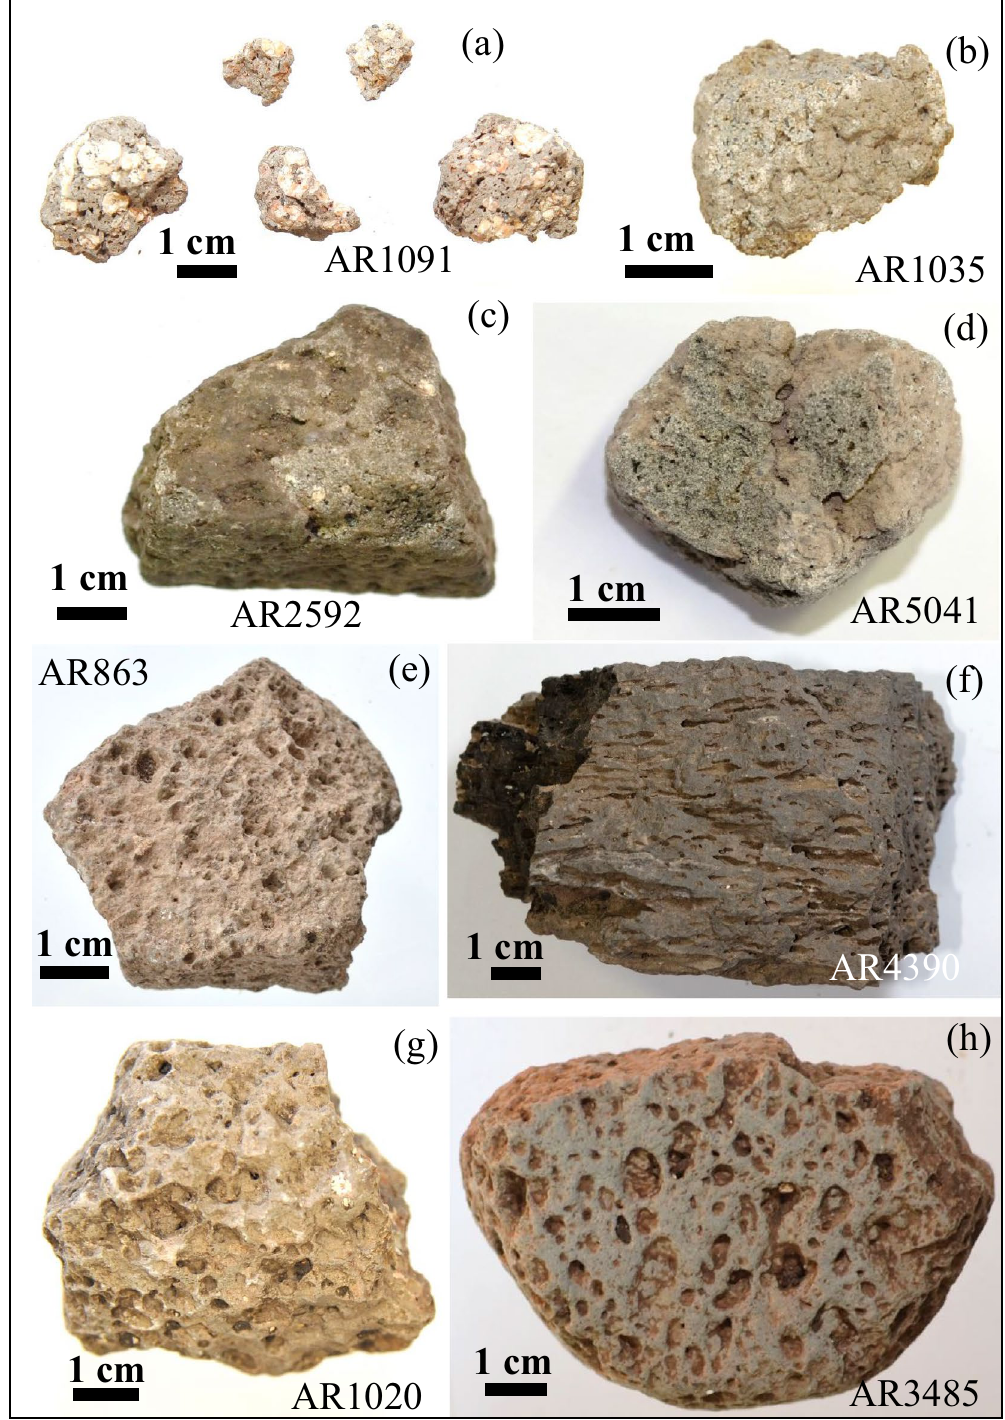
Figure 3. Macroscopic view of representative investigated fragments referable to stone grinding tools. ( a ) leucite phonolite; ( b – d ) leucite tephrites; ( e – h )